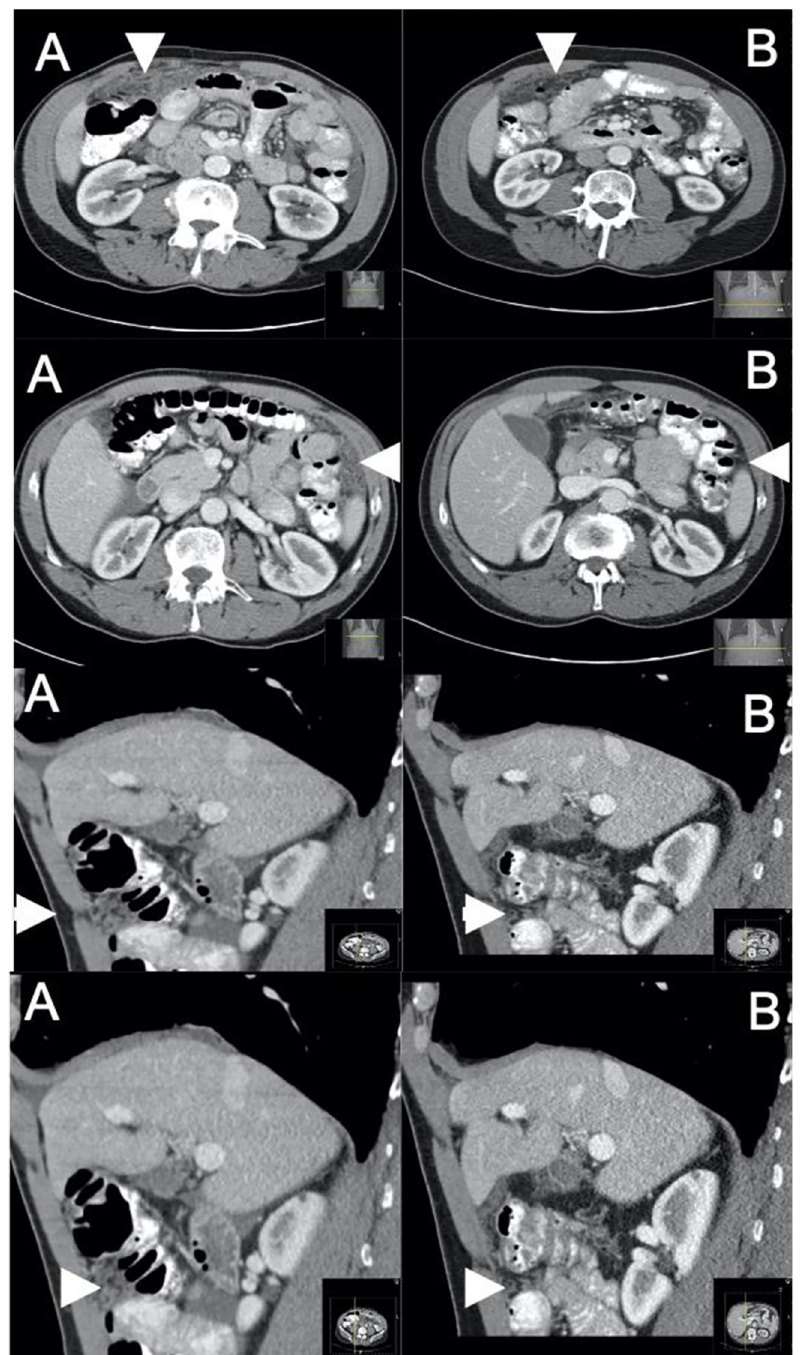
Fig 1. Partial response to neoadjuvant chemotherapy. Patient with DMPM with initial CT images prior to administration of systemic chemotherapy (A) and after six cycles of neoadjuvant carboplatin and pemetrexed (B), with marked partial response to